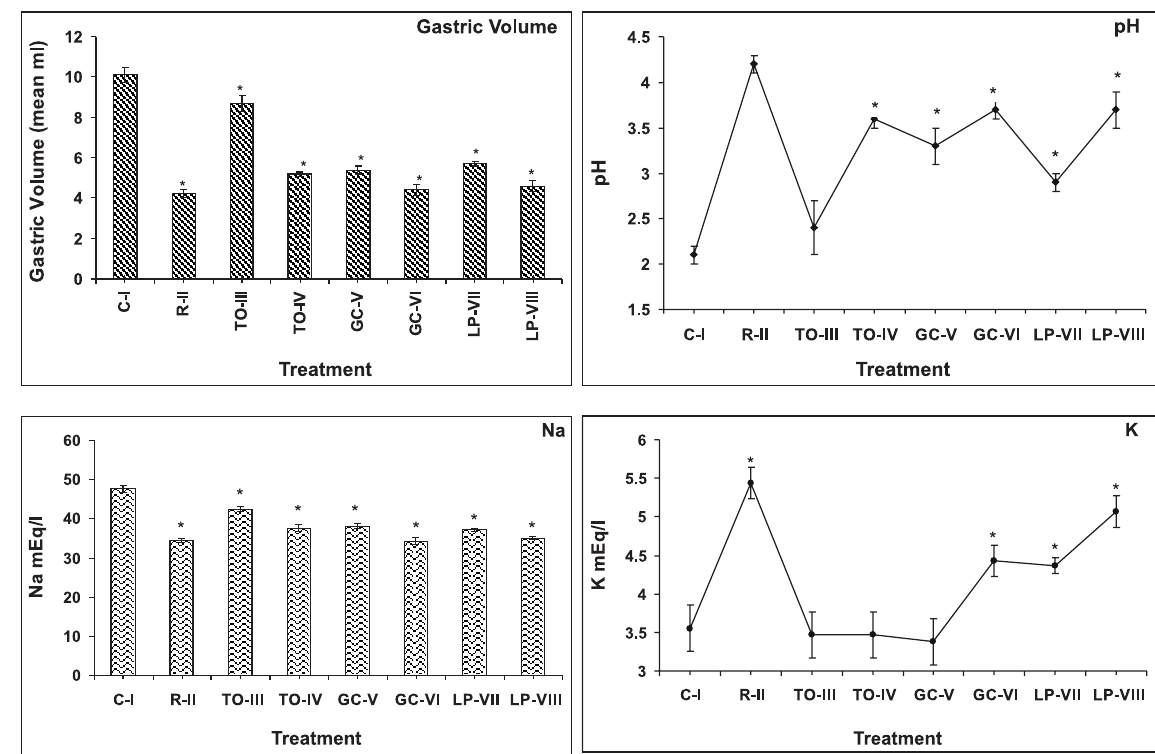
FIGURE 1 - Antiulcer activity of acetone extract of seaweed Turbinaria ornata , Gracilaria crassa and Laurencia papillosa against pylorus ligation induced gastric ulcer: Gastric Volume, pH, Na and K (Values: mean±SD of four replicates; *P<0.05 compared to control; C-Control; R-Ranitidine; TO- Turbinaria ornata ; GC- Gracilaria crassa ; LP- Laurencia papillosa ; I-VIII - Animal Groups; R-II-50 mg/kg; TO-III, GC-V & LP-VII -100 mg/kg; TO-IV, GC-VI & LP-VIII-200 TABLE I - Antiulcer activity of acetone extract of seaweed Turbinaria ornata , Gracilaria crassa and Laurencia papillosa against pylorus ligation induced gastric ulcer: Acidity, Ulcer score and % of Ulcer inhibition Dose Free acidity Total acidity Treatment Group (mg/kg) mEq/L Control